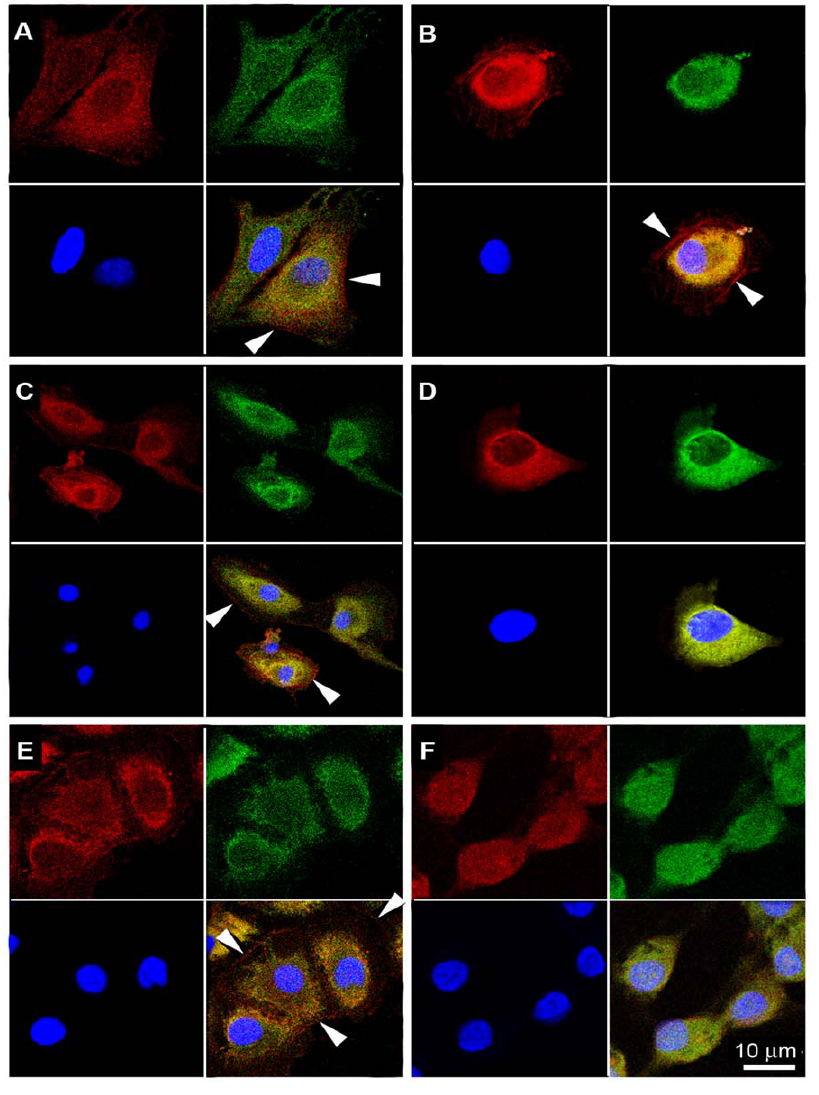
Figure 4. Cellular localization of LHCGR and morphological changes of hGLC under continuous exposure to hLH 500 (pM) by confocal microscopy. a. Unstimulated cells (control) after 1 hour. b. hLH-treated cells after 1 hour. c. Unstimulated cells after 15 hours. d. LHCGR sequestration from cell surface in hLH-treated hGLC, after 15 hours. e. Unstimulated cells after 24 hours. f. Cell-rounding in hLH-treated cells after 24 hours. LHCGR is labeled in red (Tritc), the cytoplasmic marker ERK1/2 in green (Fitch) and cell nuclei marker (DAPI) in blue. The merging of the three images is in the lower right plate of each panel. Images are from one experiment and are representative of three independent experiments with similar results. White arrows indicated LHCGR; Scale bar: 10 m m. Western blot control for the anti-LHCGR antibody and non-permeabilized cells control for immunofluorescence staining were also included (Fig. S5).